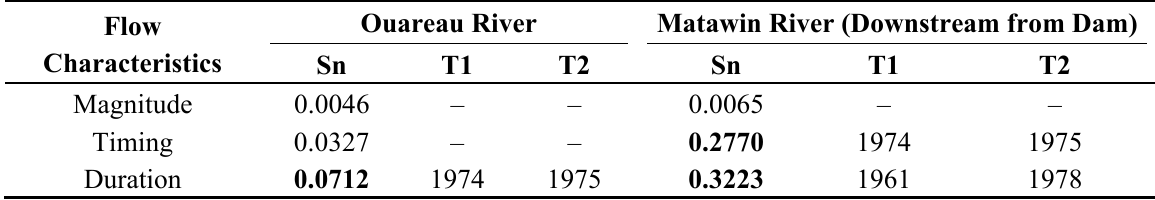
Table 5. Comparison of the stationarity of annual daily minimum flows in regulated settings using the Lombard method (1930–2010).